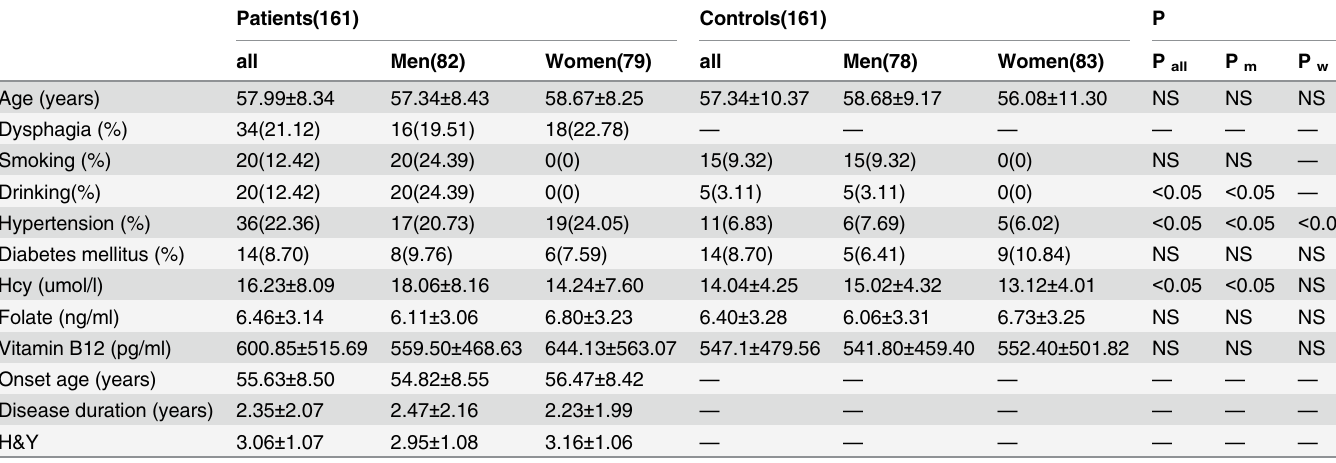
Table 1. Characteristics of patients and controls.